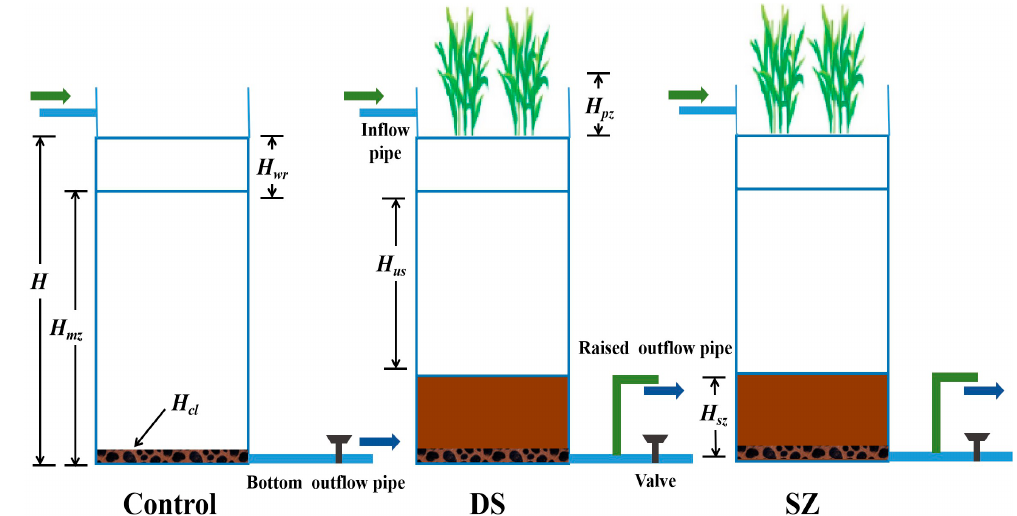
Figure 1. Schematic diagram of the bioretention columns (Control: conventional bioretention with soil, sand, and gravel; DS: column without saturation area; SZ: column with a 400 mm high-saturated zone at the bottom). Hpz: ponding zone depth, Hwr: water-retaining layer depth, Hus: unsaturated zone deepth, Hsz : submerged zone, H : depth of media layer, Hcl : catchment layer (H = Hwr + Hus + Hsz).